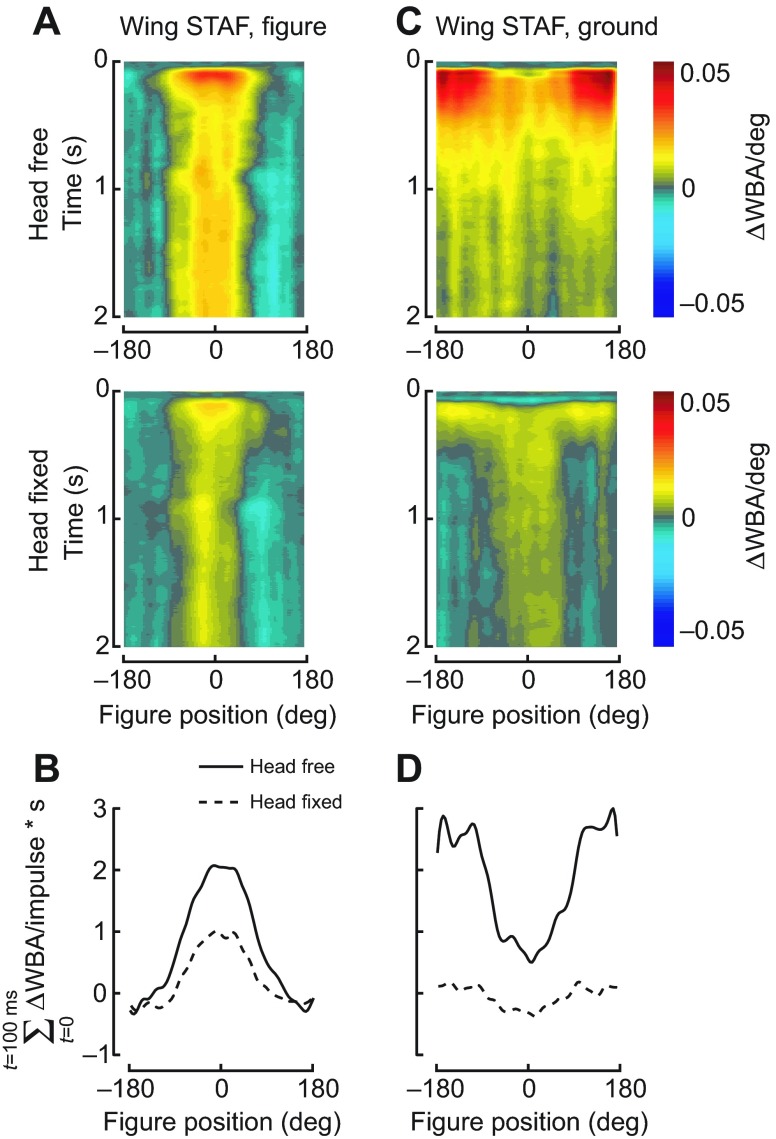
Figure and wide-field spatiotemporal action fields (STAFs) for wild-type and head-fixed flies. (A) Figure STAFs for head-free (top) and head-fixed (bottom) flies. (B) Integration of the figure STAF over the first 100 ms of the response for head-free and head-fixed flies. (C) Wide-field STAFs for head-free and head-fixed flies. (D) Integration of the wide-field STAF over the first 100 ms of the response. The wide-field response is diminished by fixing the head. Wild-type flies, N=27 [reprinted from Fox et al. (Fox et al., 2014)]; head-fixed flies, N=22. ΔWBA/deg, metric of the fly's steering response (difference between left and right wingbeat amplitudes) per degree of stimulus motion.